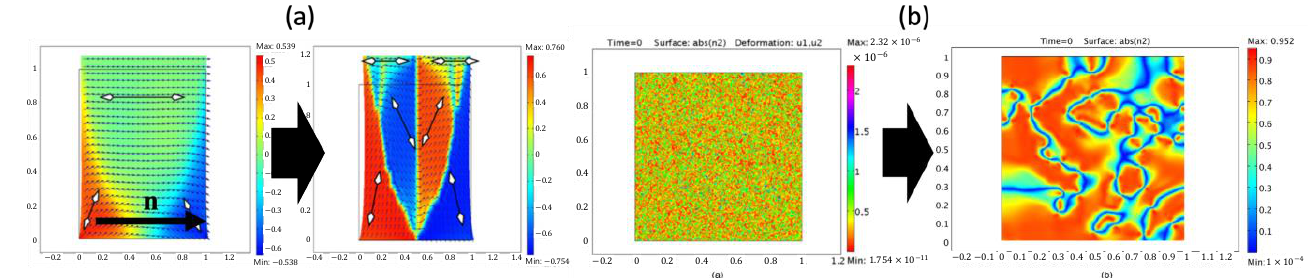
Figure 10. Dynamic texture evolution represented by pseudo-director with colorbar and arrow model, which are expressed according to the local direction. ( a ) Monodomain to stripe texture due to tension; ( b ) quenching simulation of heated LCN ( left ) to cooled LCN ( right ) (Adapted with permission from Ref. [55]. 1992, Oates, W. S et al.).